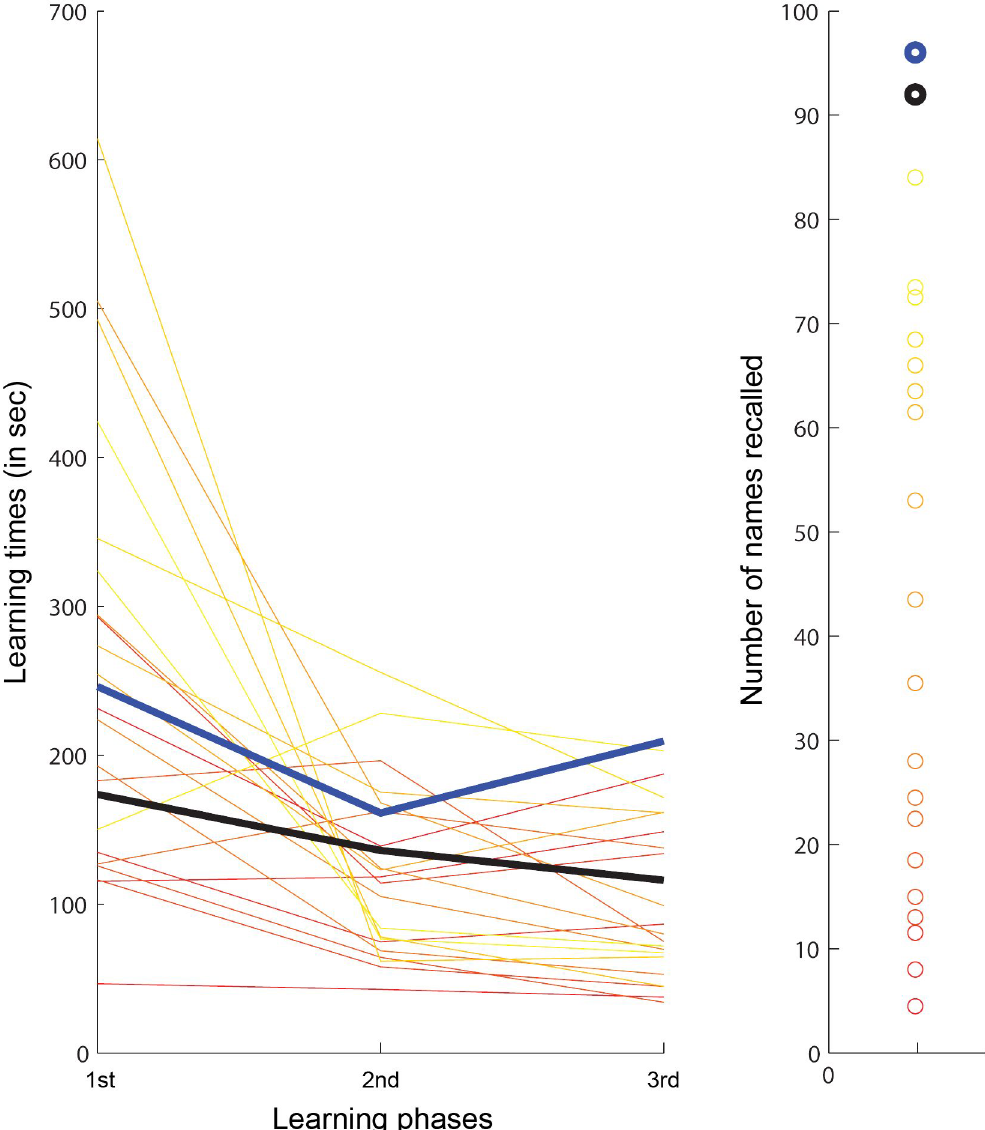
Fig 2. Individual subjects ’ results for Experiment 1: Face-name association learning with naturalistic stimuli. Subjects ’ learning times (left) and overall recognition scores (right; subjects received .5 points per correctly recalled name). Individual controls are depicted in yellow to red colors, in order to relate their learning times to the respective scores obtained; SMs ’ performance is displayed as black (SM1) and blue (SM2) lines and circles,